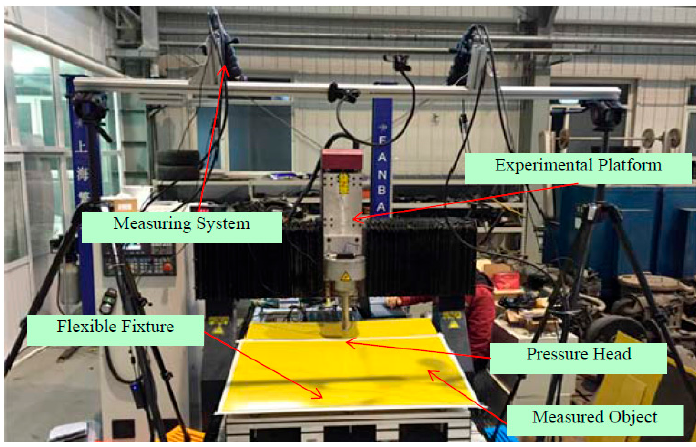
Figure 14. Experimental field measurement setup. Sensors 2017 , 17 , 40